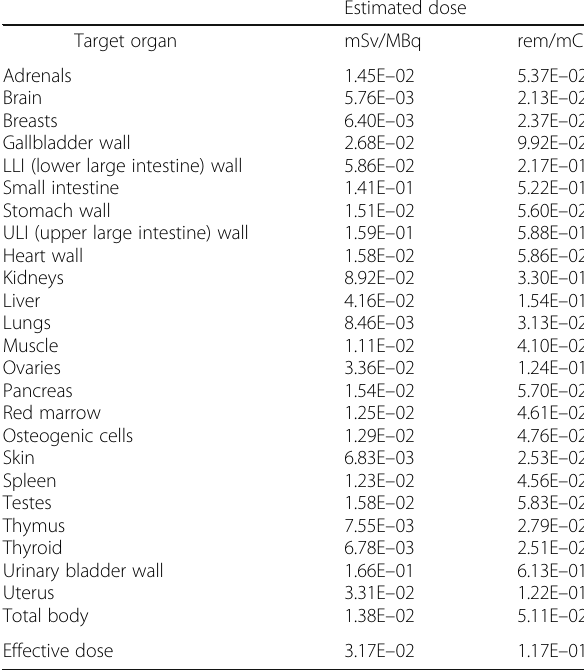
Table 4 Radiation dosimetry estimates for human (adult male) Estimated